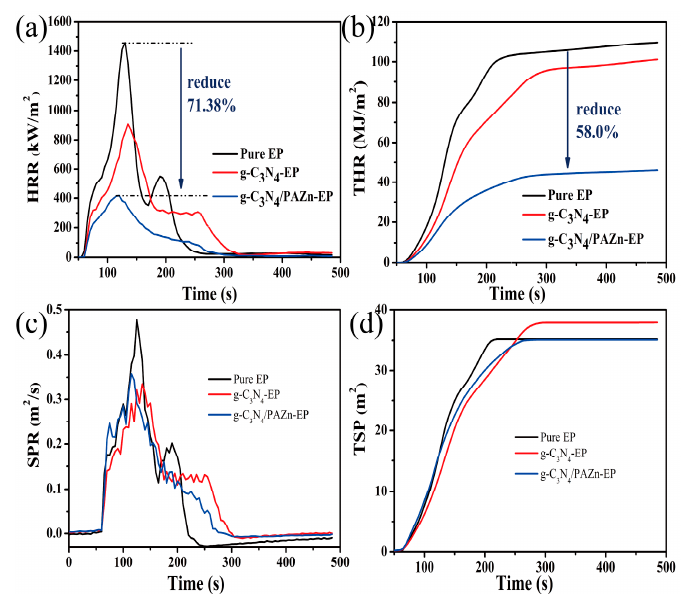
Figure 5. Heat release rate (HRR; a ); total heat release (THR; b ); smoke production rate (SPR; c ) and total smoke production (TSP; d ) curves of EP composites.